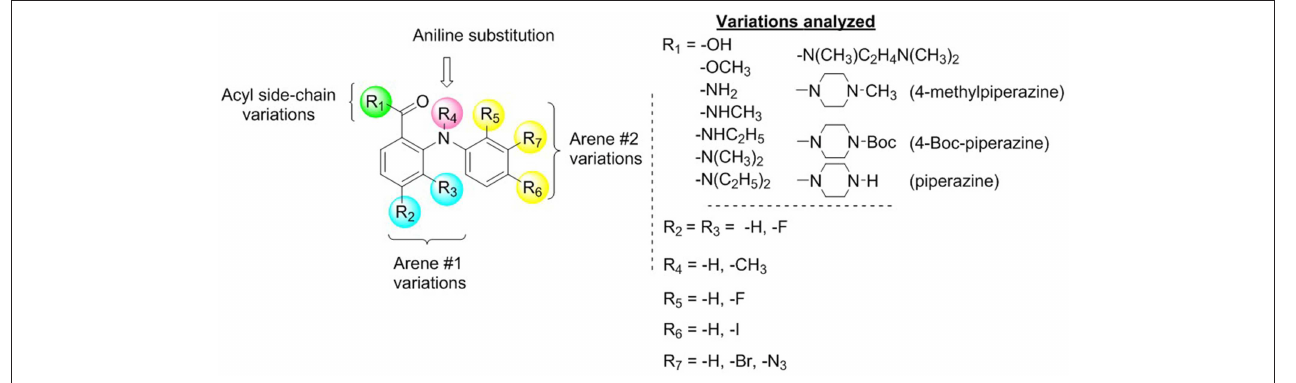
FIGURE 2 | Identification of diphenylamine scaffold as an activator of